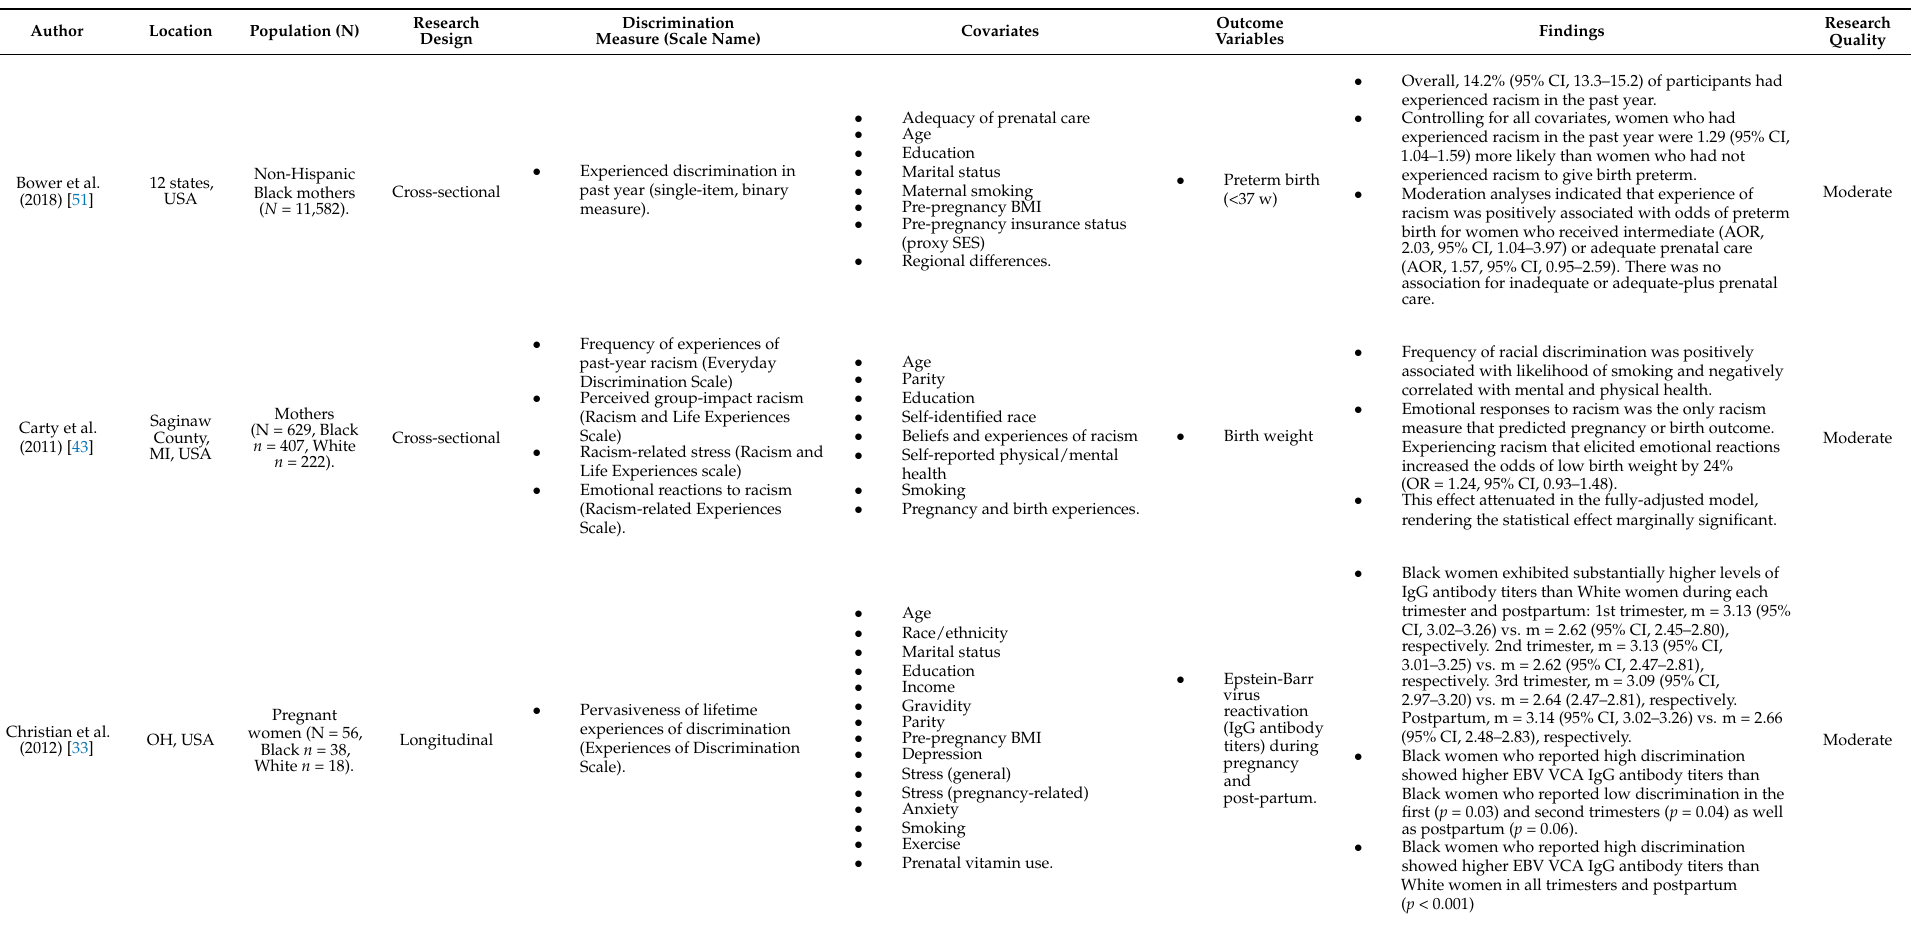
Table 1. Design, samples, and methodology for research studies included in present